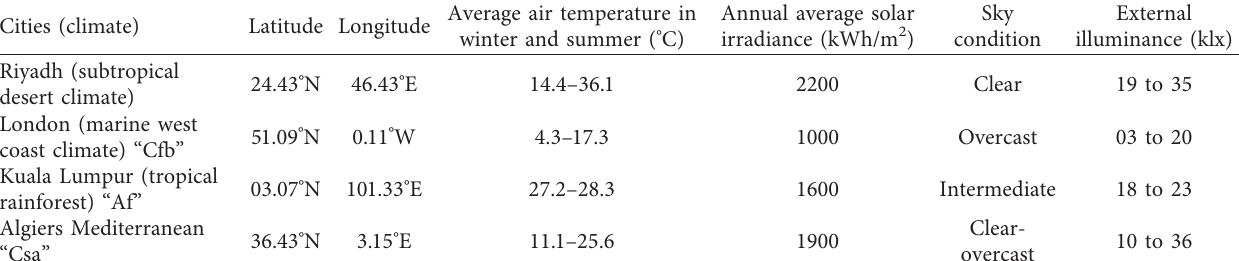
Table 1: Climatic conditions of different cities used in this study.